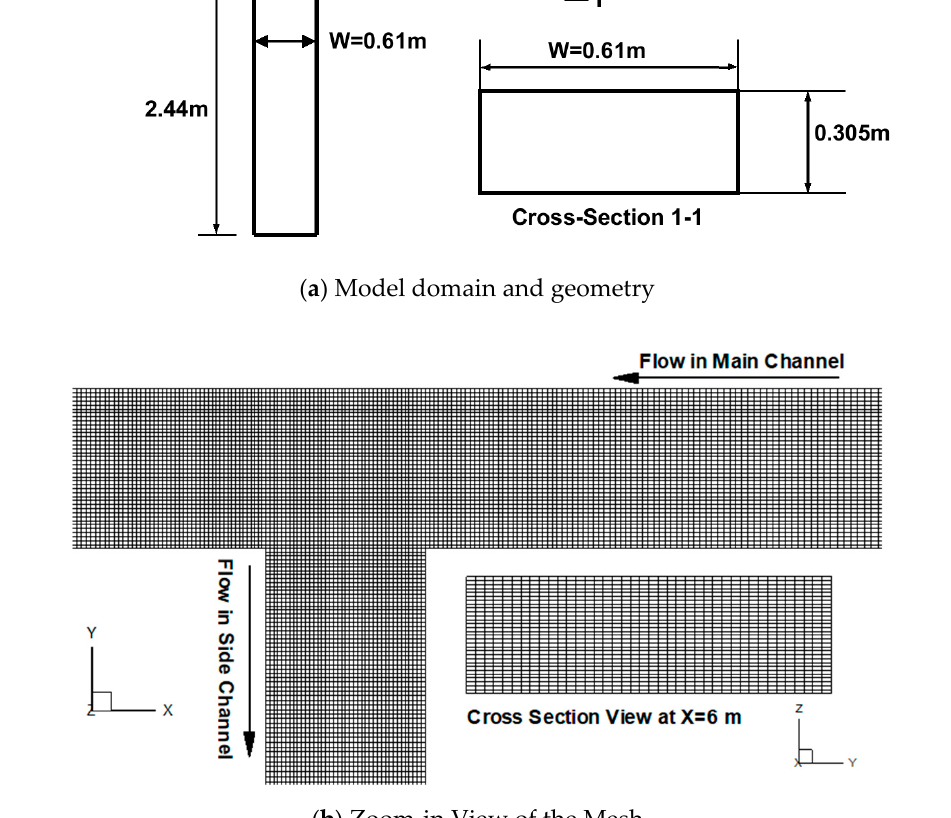
Figure 2. Model domain and dimensions of the juncture ( a ) and the mesh of the baseline model ( b ). The simulated results are compared with the laboratory data of Ramamurthy et al.